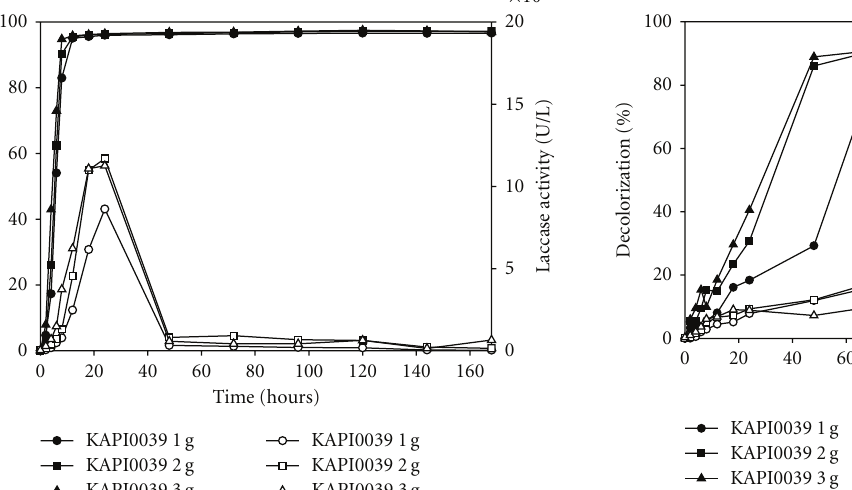
Figure 4: The e ff ect of fungal inoculum size on %decolorization of RB5 dye solution and Lac activity after cultivation with Datronia sp. KAPI0039; close symbol = %decolorization; open symbol = Laccase